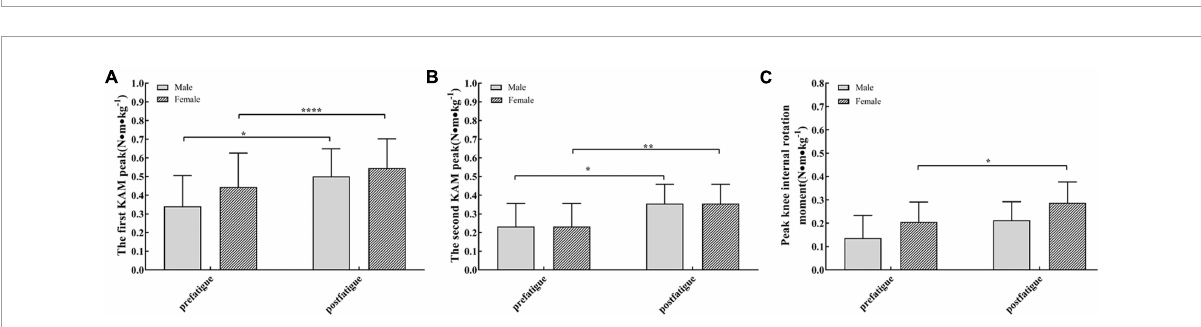
FIGURE9 (A) The first peak of external knee adduction moment in female (bar with oblique line) and male participants (dark bars) was significantly different after fatigue. (B) The second peak of external knee adduction moment was significantly different after fatigue in men (dark bars) and women (bar with oblique line). (C) The peak knee internal rotation moments (mean and standard error) were significantly different after fatigue in men (dark bars). * P < 0.05, ** P < 0.01, **** P <